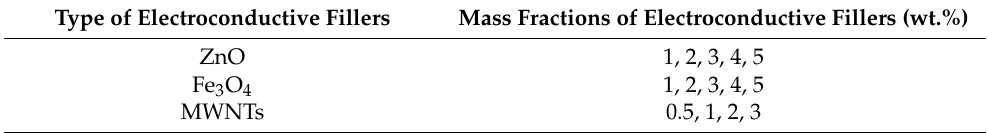
Table 1. Mass fractions of different electroconductive fillers.